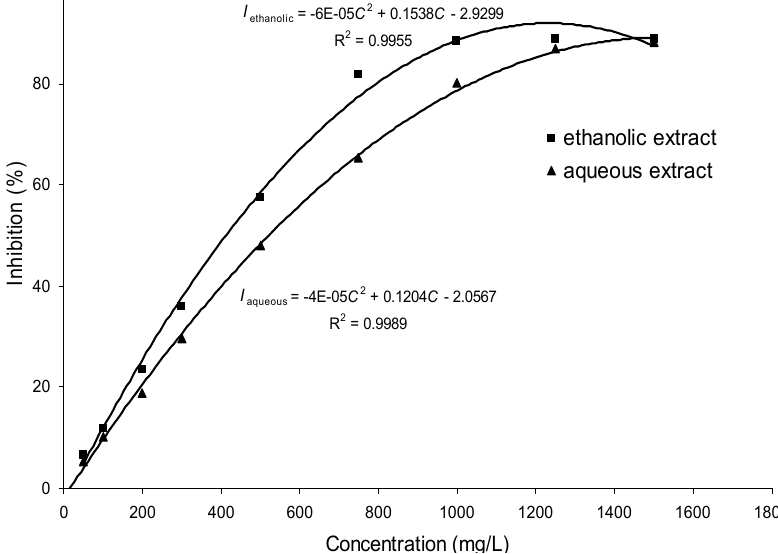
Figure 4. DPPH radical scavenging capacity two SL extracts ( n =